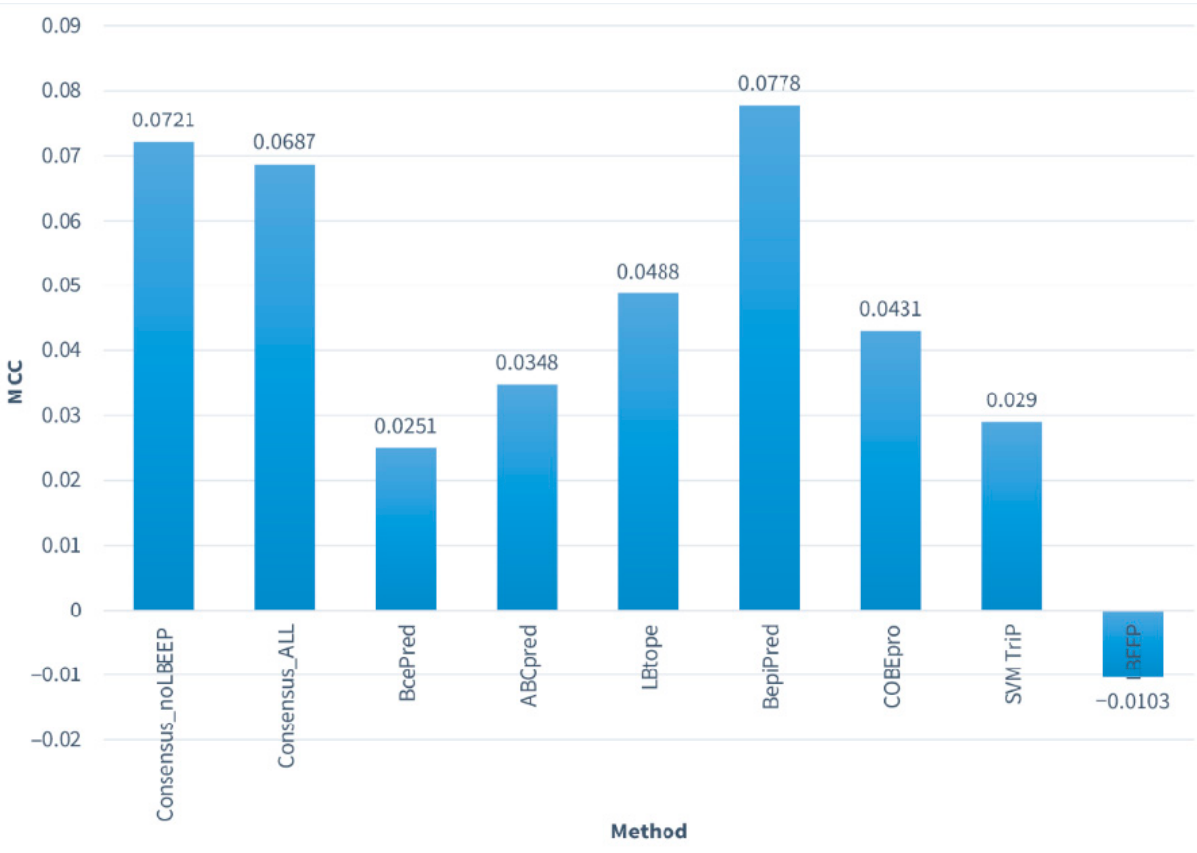
Figure 1. Matthews Correlation Coefficient (MCC) values achieved by all methods tested on the Consensus_NR data set at 20 amino acid residues in “per peptide” mode. The vertical axis represents the MCC value for all the methods and the horizontal axis the names of these methods. The best MCC is achieved by the BepiPred method, followed closely by our Consensus methods, while the worst performers are the LBEEP, SVMTriP, and BcePred methods.